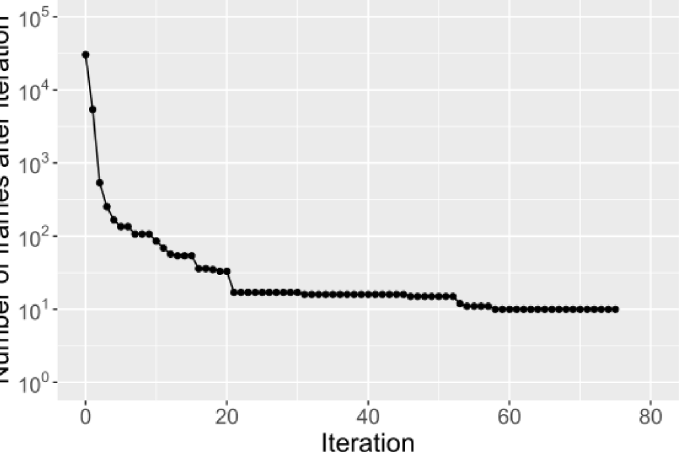
Fig 2. Iteration plot. Number of frames that met the filter criteria after each iteration. At the 0th iteration all frames of the reference genome are present. The 1st iteration is the comparisonto the non-pseudintermedius genomes.All followingiterations are comparisons to S . pseudintermedius genomes.